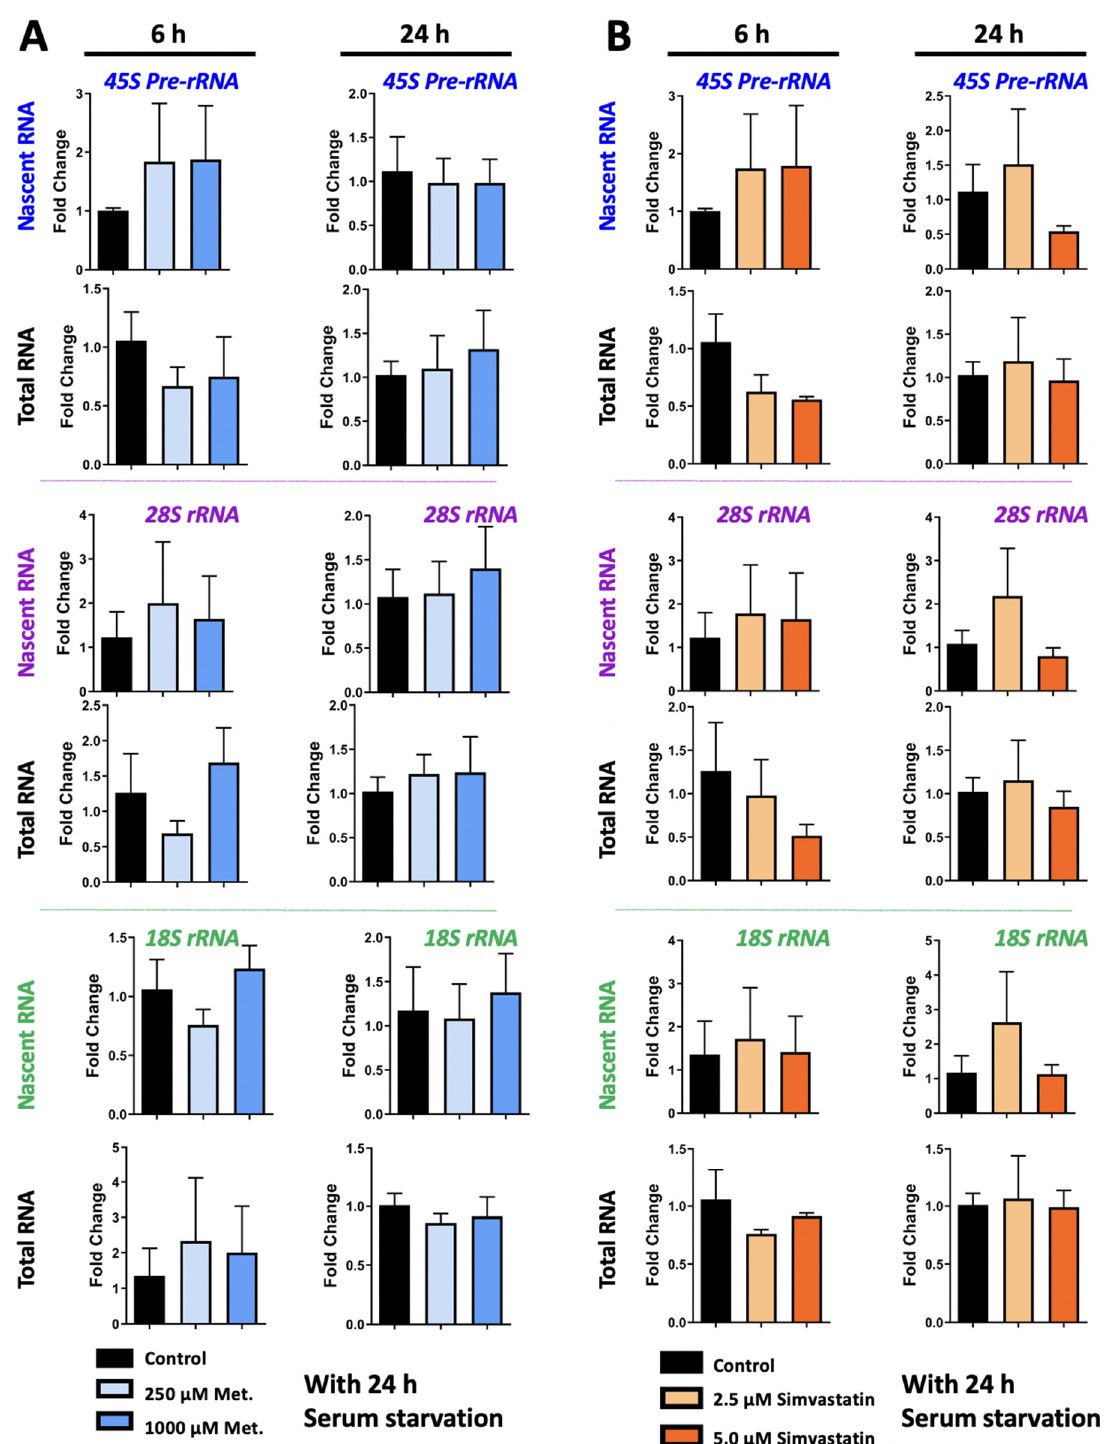
Figure 6. Transcriptional effect of individual metabolic drugs; metformin and simvastatin, on ribosomal RNA genes in Daoy cells. Cells were serum-starved for 24 h prior to drug treatment with 250 µ M and 1000 µ M metformin ( A ), or simvastatin ( B ) at two concentrations of 2.5 and 5.0 µ M. Samples were collected at 6 and 24 h and gene expression was analyzed by RT-PCR for 45S pre-rRNA , 28S rRNA , and 18S rRNA transcripts. C T values were normalized to the housekeeping gene GAPDH and fold change was determined relative to the average control. N = 3 ± SEM. Fold change values were analyzed by one-way ANOVA followed by Tukey’s multiple comparisons test.